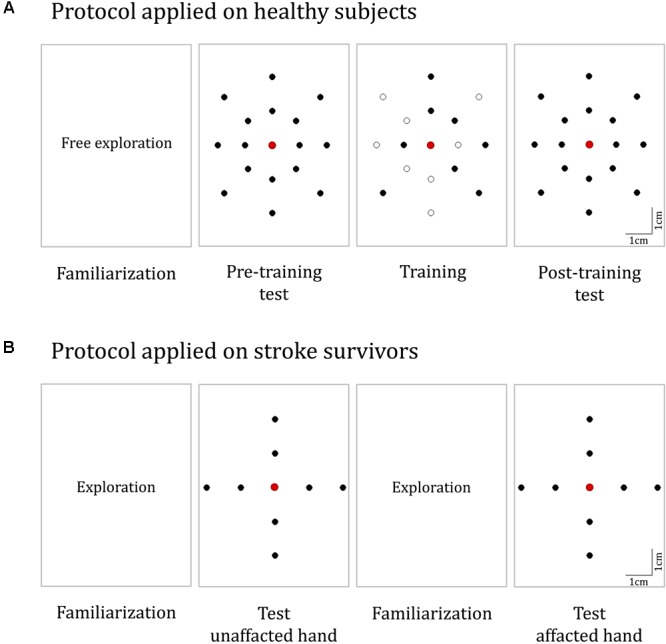
Experimental protocols. (A) The protocol for healthy participants. It consisted of four phases: familiarization, pre-training test, training, and post-training test. During familiarization, the Tactile-STAR was placed in active mode and the subjects moved the handle of the recorder device to produce stimulator end-effector motions that were identical in magnitude and direction to the movements of the recorder endpoint (handle). In both the test phases, 16 test targets located on two concentric ellipses were presented five times in random order. During training, a subset of eight targets was presented nine times each. (B) The protocol for the validation experiments with stroke survivors. The test was performed on both hands, and for each hand, we had both a familiarization and a test phase. The targets for the test phase are placed in the four cardinal directions on two concentric circles.